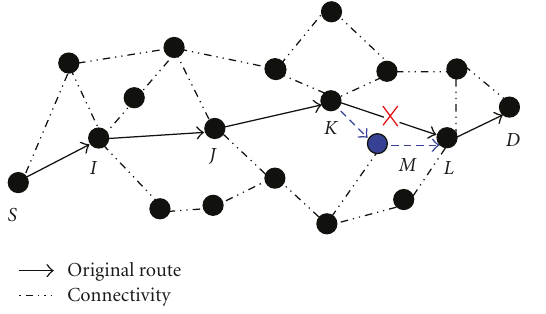
Figure 1: Route maintenance using Bypass-AODV.